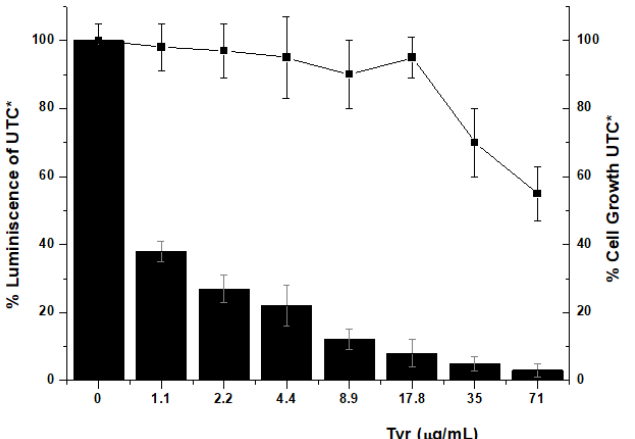
Figure 4. Inhibition of the hepatitis C virus (HCV) replicon in cell assays using a purified protein sample containing both TyrAB and Tyr50 kDa . Evaluation of the potency and cytotoxicity of the protein in cell (Huh-5-2) assays. HCV replicon replication rate (luminescence, black bars) and cell survival (closed squares) were independently measured in cell culture by increasing protein concen- tration to determine EC 50 . * All luminescence and viability values were normalized considering the untreated control values (UTC).